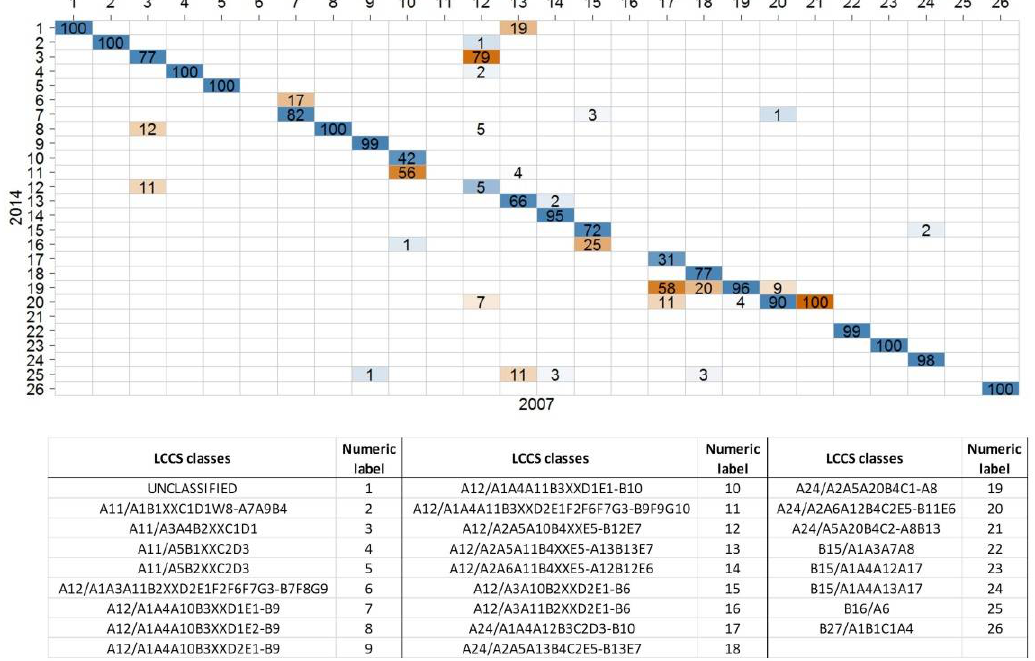
Figure 8. LCCS habitat class transition matrix for 2007 to 2014 for the CE site.